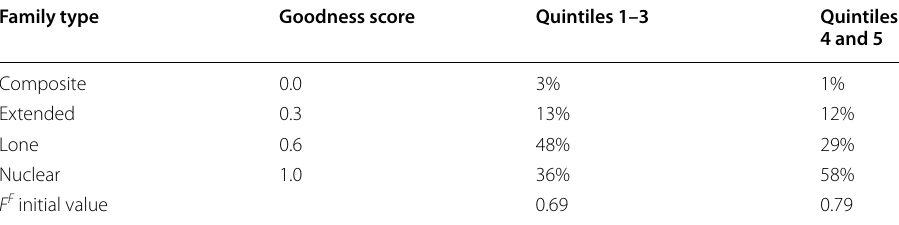
Table 2 Average percentage of children per socio-economic quintile in each of the four family types